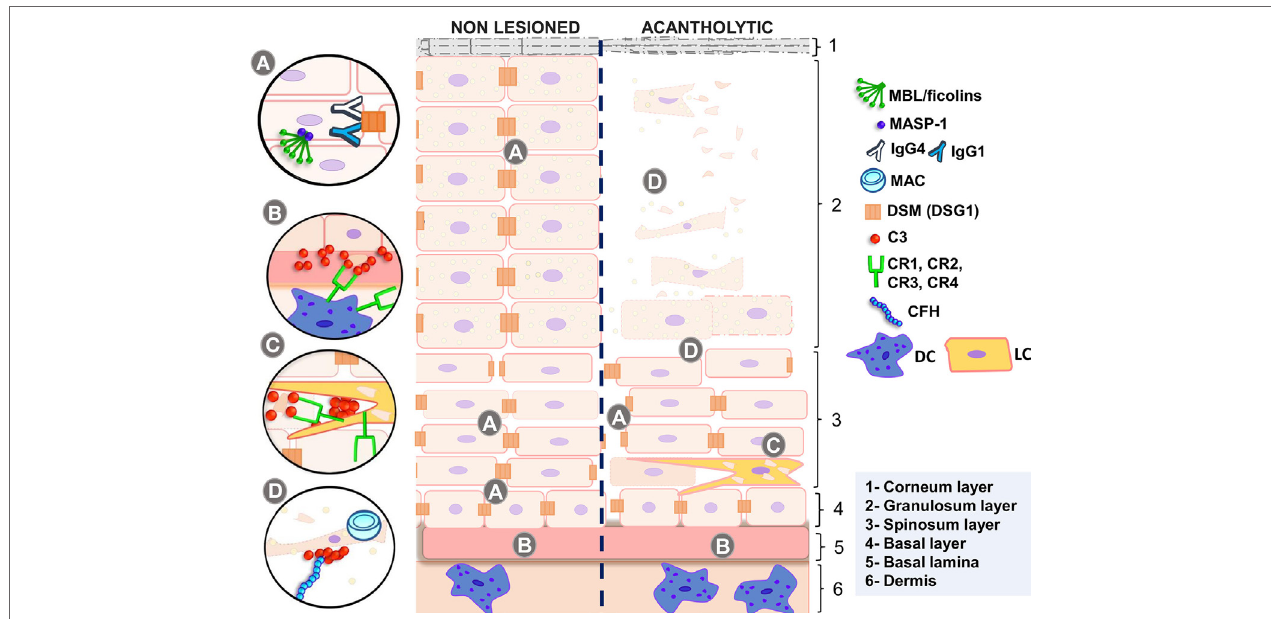
FiGUre 1 | Complement in non-lesioned and acantholytic PF lesions. (A) IgG1 and IgG4 autoantibodies binding to desmosomes causes shrinkage of keratinocytes, increasing intercellular spaces. This process is fostered by activation of the p38 MAPK signaling cascade, which may be unleashed by MASP-1, the serine protease associated with initiating molecules of the lectin pathway. (B) This is further accompanied by the release of antigens, most probably recognized by MBL or ficolins, leading to granular deposition of C3 fragments in the basal lamina. These deposits, as well as deposits of C3 fragments in the intercellular spaces, may also be caused by activation of the alternative pathway, inhibited by CFH. (c) Complement receptors recognize C3 fragments, leading to phagocytosis of autoantigens and increasing antigen presentation to T lymphocytes, thus feedbacking and diversifying autoantibody production. (D) Acantholytic lesions present formation of the membrane attack complex (blocked by CD59 expression), which may protect cells against apoptosis, if present in sublytic amounts. Active disease is also followed by increased C5a release, the latter recognized by C5A receptors in dendritic cells. MBL, mannose-binding lectin; MASP-1, mannose-binding lectin serine protease 1; MASP-2, mannose-binding lectin serine protease 2; MAC, membrane attack complex; IgG4, immunoglobulin 4; IgG1, immunoglobulin 1; DSM (DSG1), desmosome (desmoglein 1); C3, complement component 3; CR1, complement receptor type 1; CR2, complement receptor type 2; CR3, complement receptor type 3; CR4, complement receptor type 4; CFH, complement factor H; DC, dendritic cell; LC, Langerhans cell; PF, pemphigus foliaceus. Source: the author